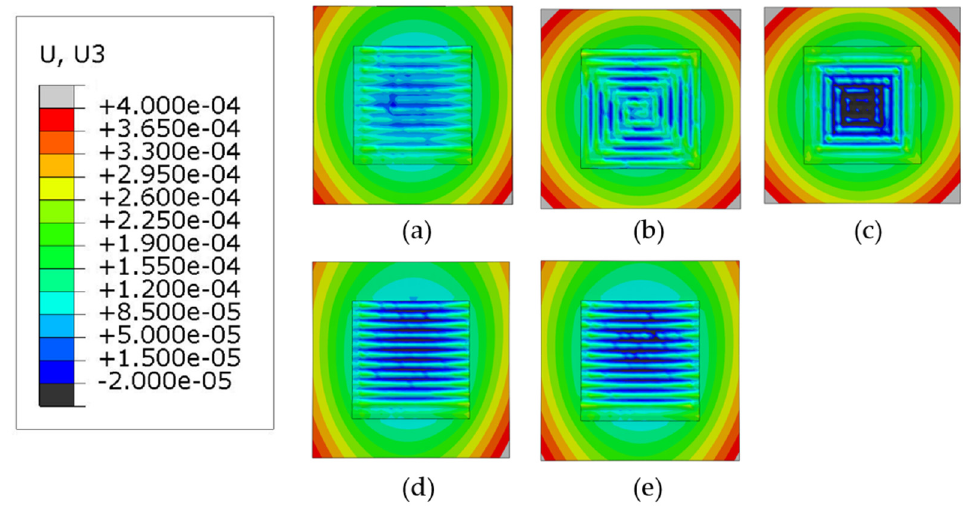
Figure 14. Deformation distribution of different deposition patterns at the end of the simulation, when phase transformations are considered, (top view, unit: m); ( a ) alternate, ( b ) in–out, ( c ) out–in, ( d ) raster, ( e ) zigzag.